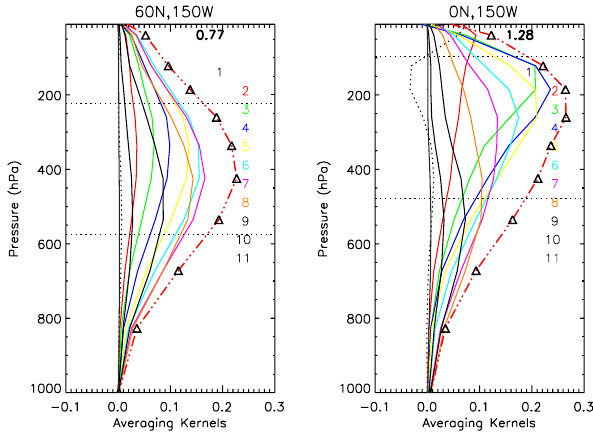
Fig. 2. The 11 trapezoidal perturbation functions for the IASI CH 4 retrieval.